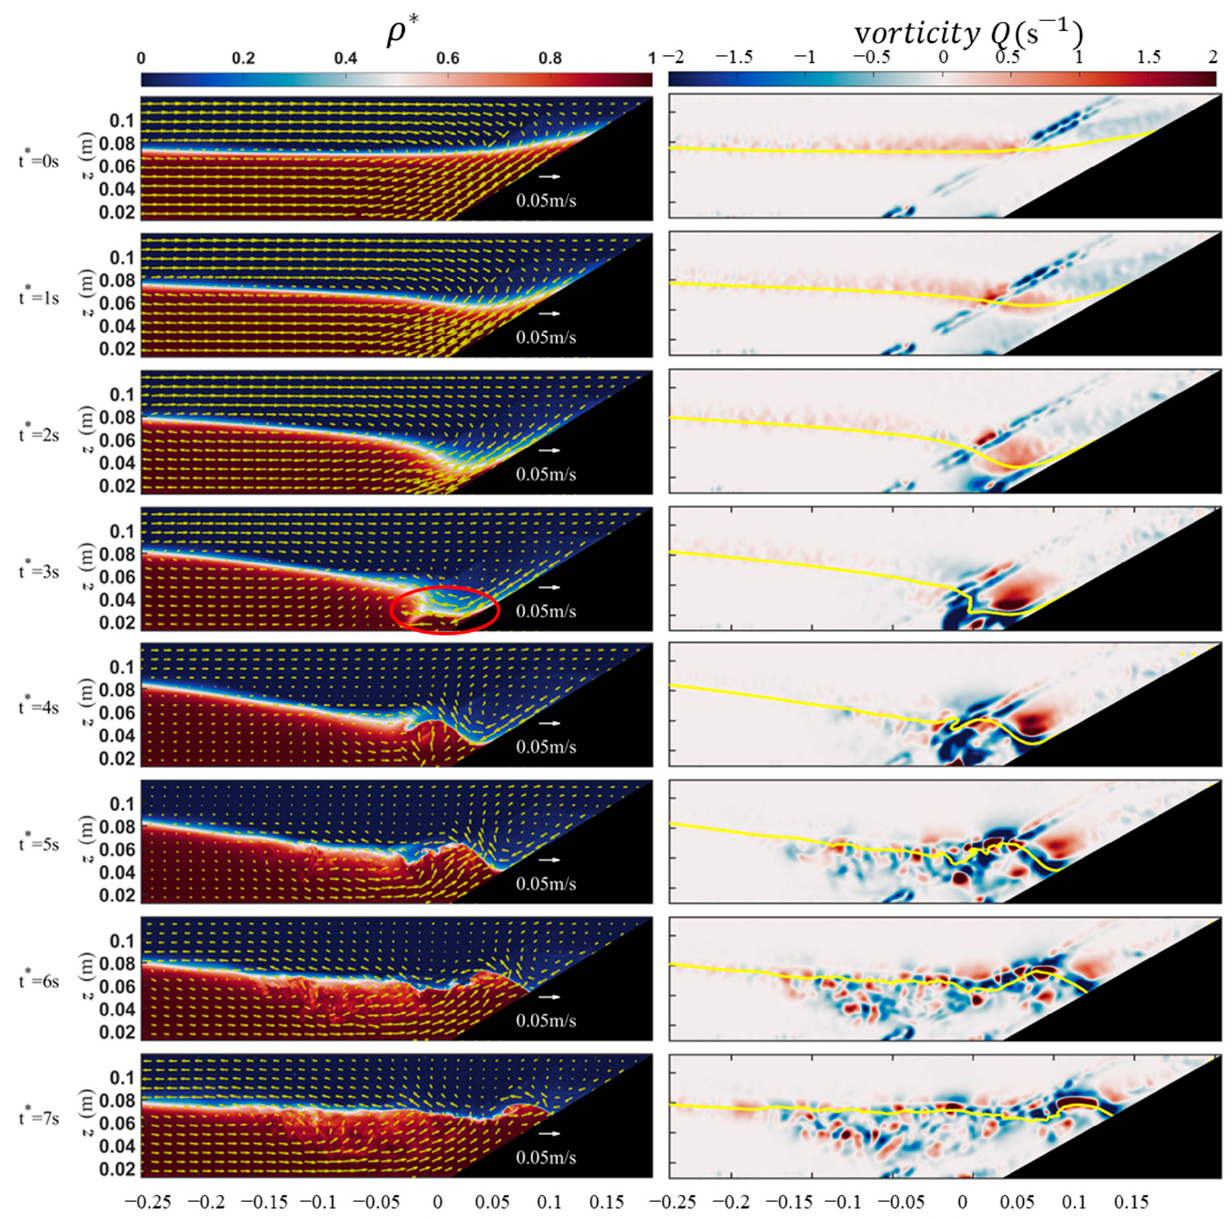
Figure 5. Density field and vorticity field of ISW evolution processes in Run 75-8.